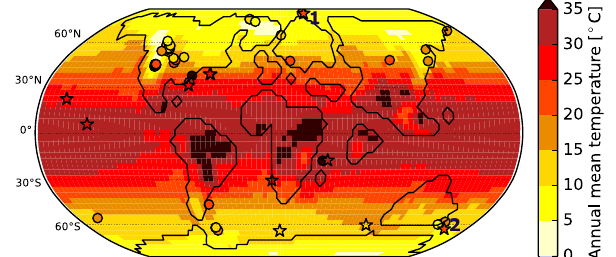
Figure 1. Annual mean 2m temperature for the early Eocene simu- lation in shaded colours. Stars show reconstructed annual mean sea surface temperature (SST) and near-surface temperature of the early Eocene derived from δ 18 O, Mg/Ca, and TEX 86 (Lunt et al., 2012). Numbers 1 and 2 mark SST reconstructions by Sluijs et al. (2006) and Bijl (2009), respectively. Circles refer to terrestrial annual mean temperature estimates based on macrofloral and palynoflora assem- blage data and from teeth, hydrogen isotopes, and oxygen isotopes (Huber and Caballero,